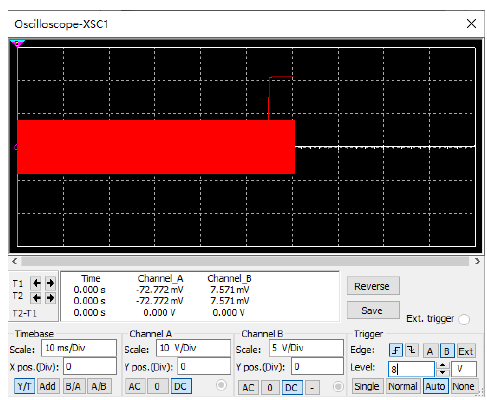
Fig. 4. Short circuit protection simulation